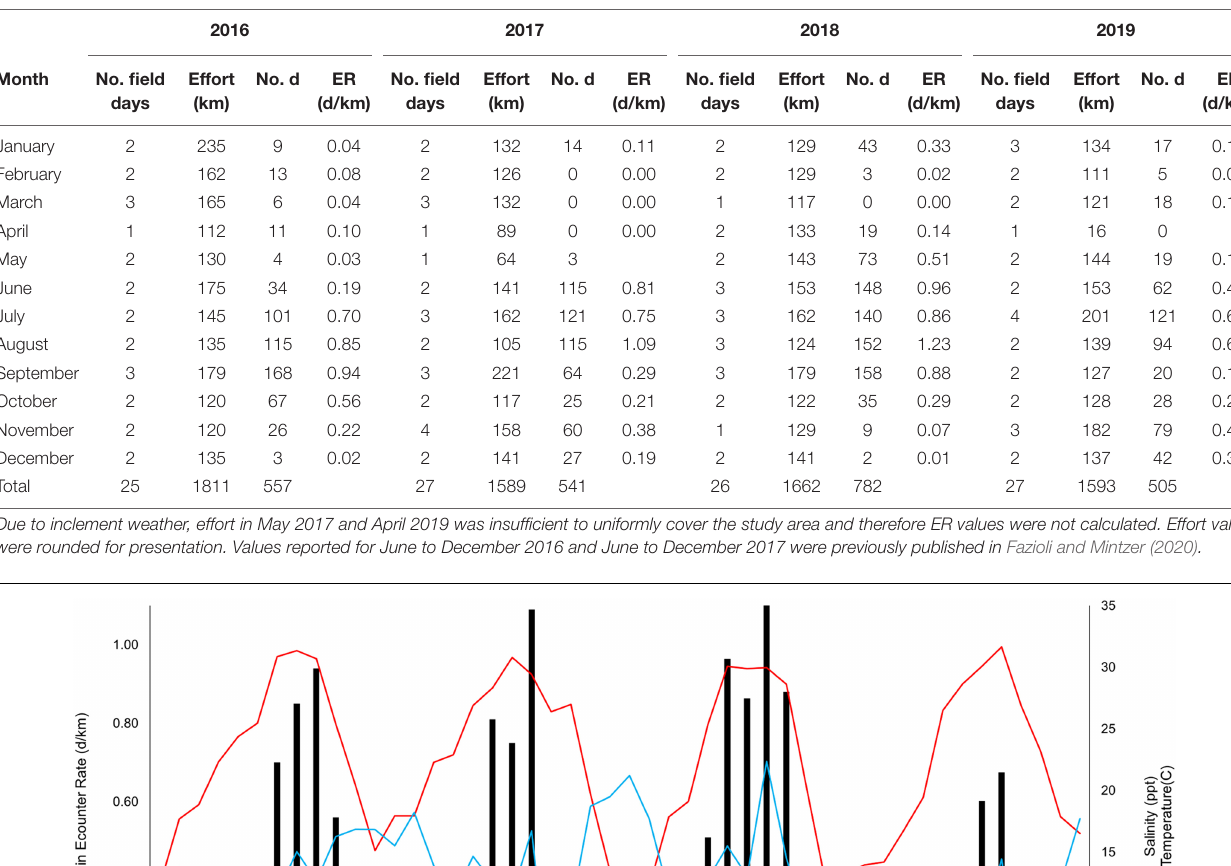
TABLE 1 | Number of boat-based field days, linear visual survey effort (km), number of bottlenose dolphins sighted (No. d), and corresponding encounter rates (ER, d/km) of bottlenose dolphins ( Tursiops truncatus ) in upper Galveston Bay, Texas from January 2016 to December 2019.